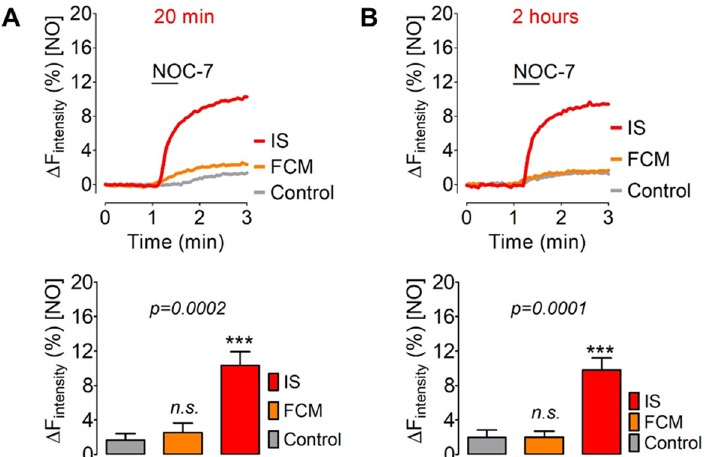
Figure 3. Evaluation of the effectiveness of IS and FCM in cultured Eahy.926 cells to activate geNOps. ( A ) The upper panel shows representative real-time traces of intracellular NO signals in response to 10 µ M NOC-7 reflecting the labile iron pool in Ea.hy926 cells upon treatment with IS (red curve) or FCM (orange curve) vs. control cells (grey curves). Cells were pretreated with 500 µ g iron/mL with the respective drug for 20 min before the imaging experiment. The lower panel shows statistical analysis. Control (grey curve, n = 3/46), FCM (orange curve, n = 3/47), and IS (red curve, n = 3/55). Panel ( B ) shows the same experimental setup as in panel ( A ), with the difference that cell pretreatment with IS and FCM was extended to 2 h. Control (grey curve, n = 3/29), FCM (orange curve, n = 3/28), and IS (red curve, n = 3/32). All values are given as mean ± SD, and Dunnet’s multiple comparison test was applied. ( A ) *** p = 0.0002, ( B ) *** p = 0.0001.